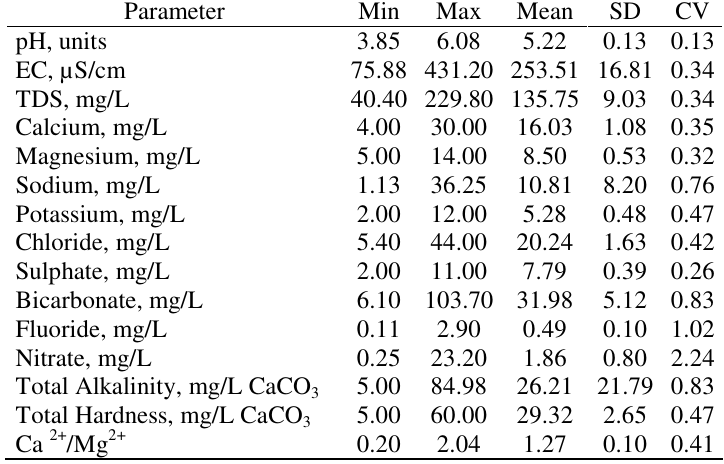
SD = standard deviation, CV = coefficient of